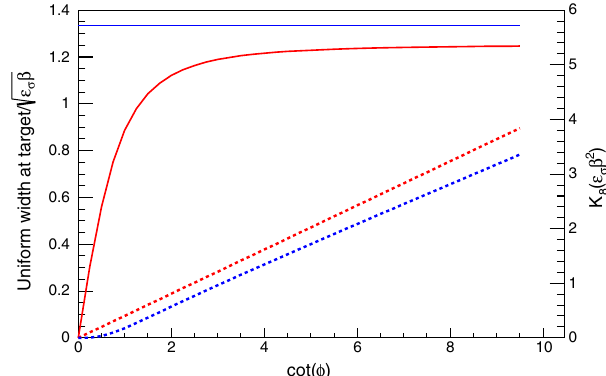
FIG. 2. Dependence of phase advance as a function of cot ϕ for uniform beamwidth at target shown on the left-hand axis as solid lines described from Ref. [29] and Eq. (13) derived from Ref. [23], respectively, denoted by red and blue lines. The required octupole strength ( K 8 ) is shown on the right-hand axis as dotted lines, as obtained by calculation using Eqs. (12) and (14), respectively. On the vertical axis in the figure is shown the beamwidth σ and the octupole strength K 8 multiplied by ffiffiffiffiffiffiffiffi p t 1 = ϵ β and ϵ σ β 2 1 , σ t